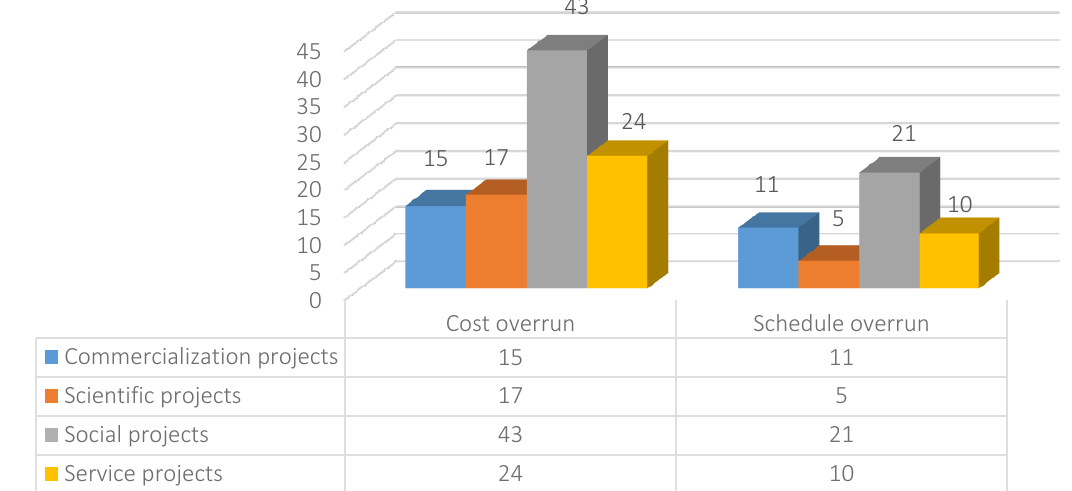
Figure 3. Project efficiency